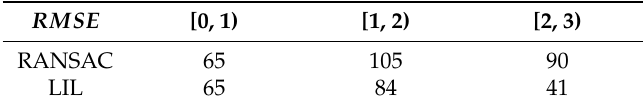
Table 7. RMSE distribution of correct matches detected by RANSAC and LIL outlier removal (image pair